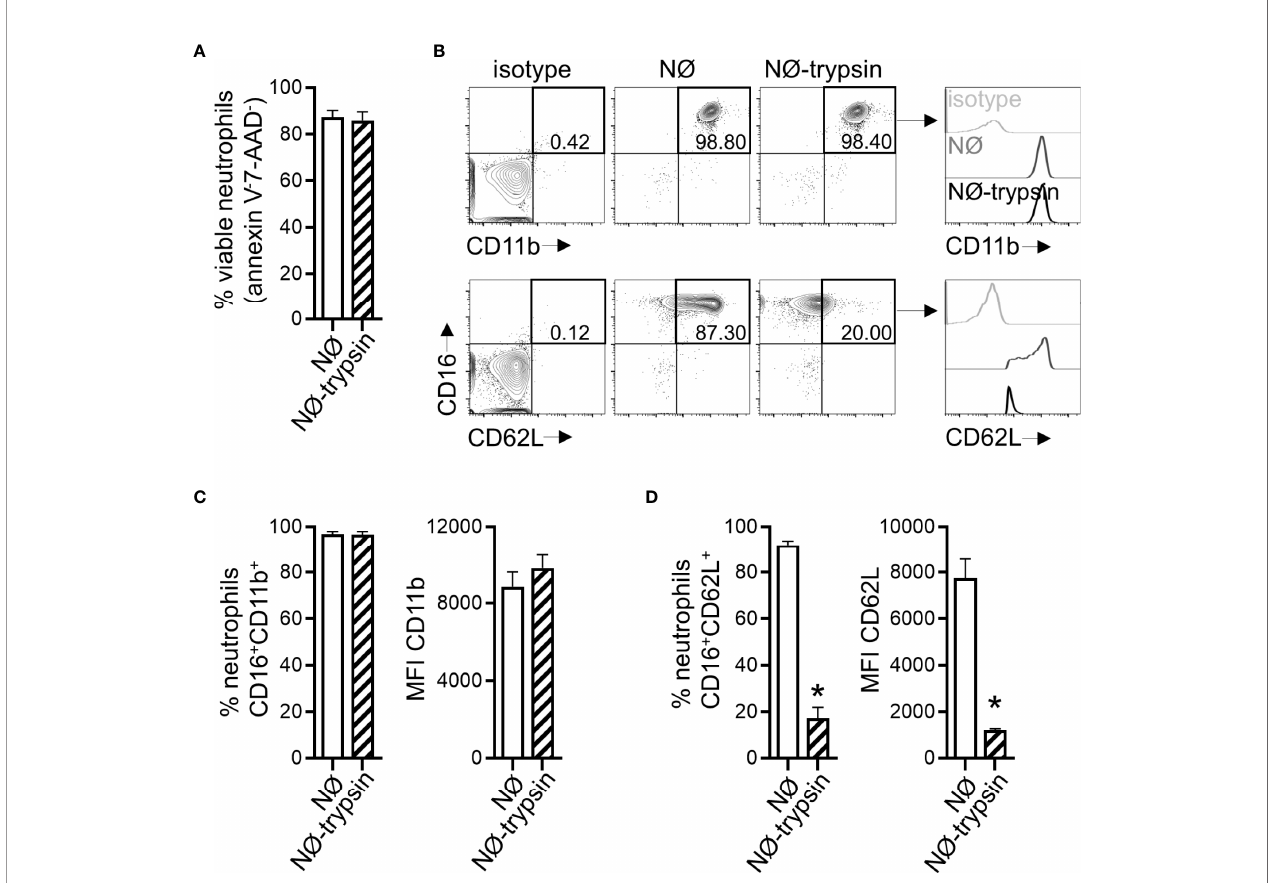
FIGURE 7 | Trypsin treatment affects the expression of CD62L in neutrophils. (A) Frequency of viable neutrophils (annexin V - 7AAD - ) after treatment with trypsin. (B) Contour plots depicting the frequency of neutrophils CD16 + CD11b + and CD16 + CD62L + and the fl uorescence intensity of CD11b and CD62L molecules inside these populations directly after isolation from blood (NØ) or in trypsin pretreated neutrophils (NØ-trypsin). Isotype control antibodies were used as a negative fl uorescence control to set the gates. (C) Frequency of neutrophils CD16 + CD11b + and the mean fl uorescence intensity (MFI) of CD11b in that population after treatment with trypsin. (D) Same analysis as in (C) was applied to the CD62L molecule. Bars indicate SEM. Two independent experiments are shown (n = 6 – 7). The asterisk (*) denotes the statistical difference between neutrophils treated with trypsin (D) and those not treated. NØ,